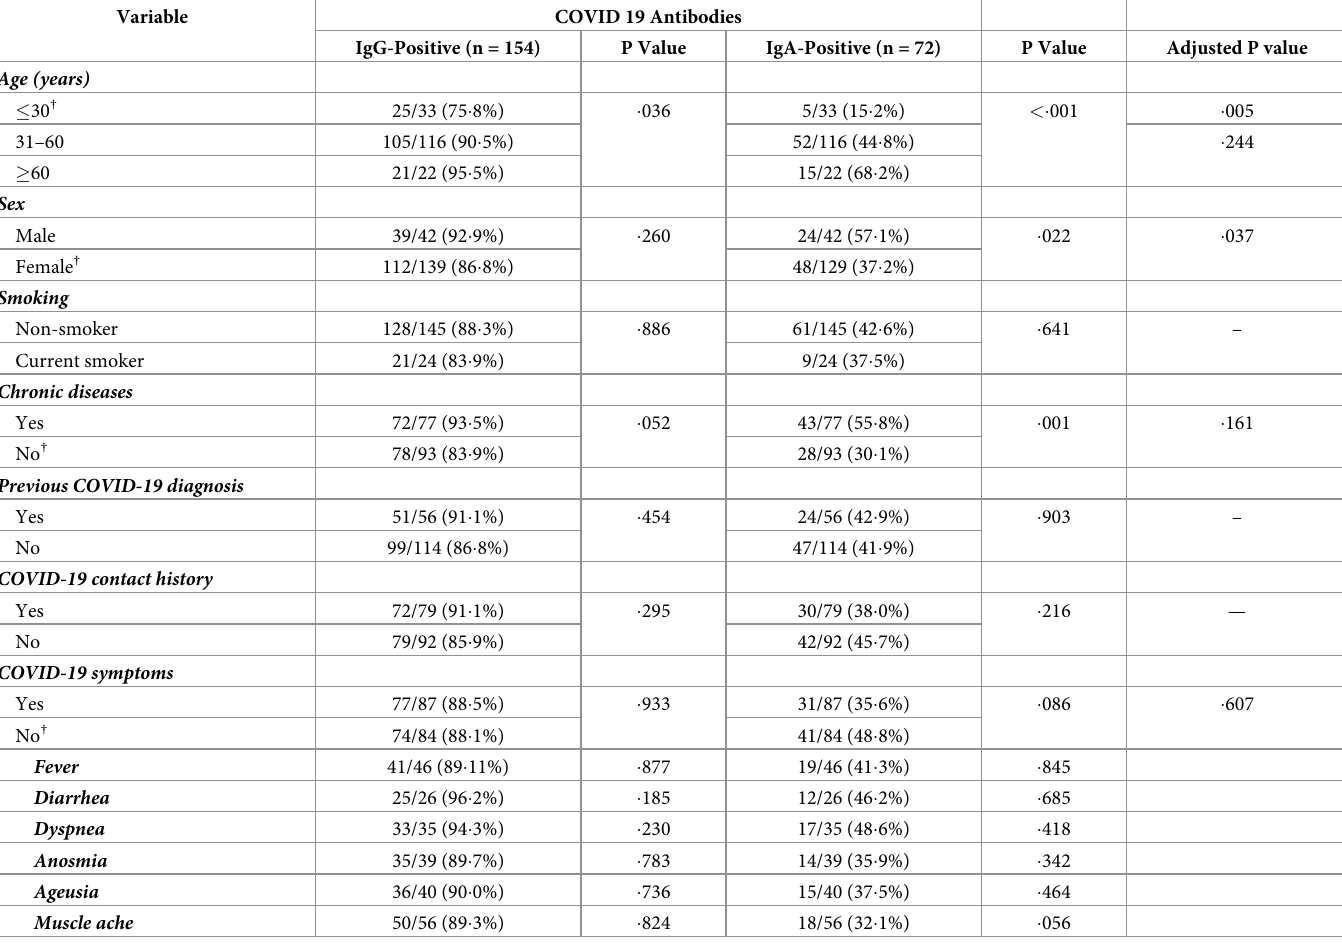
Table 4. Distribution of IgG and IgA specific antibodies according to background and clinical characteristics (n = 171).